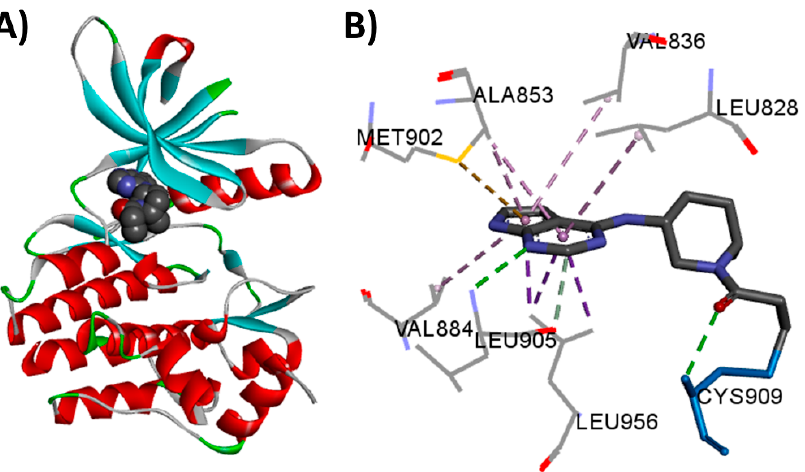
Figure 7. JAK3 (pdb: 5TOZ) bound to ritlecitinib: ( A ) 3D representation of JAK3 bound to ritlecitinib (shown as CPK); ( B ) 3D binding mode of ritlecitinib showing one covalent bond with Cys909, hydrogen bonds (shown as green-dotted lines), and multiple hydrophobic interactions, this figure was generated using Discovery Studio Visualizer (V16.1.0.15350).